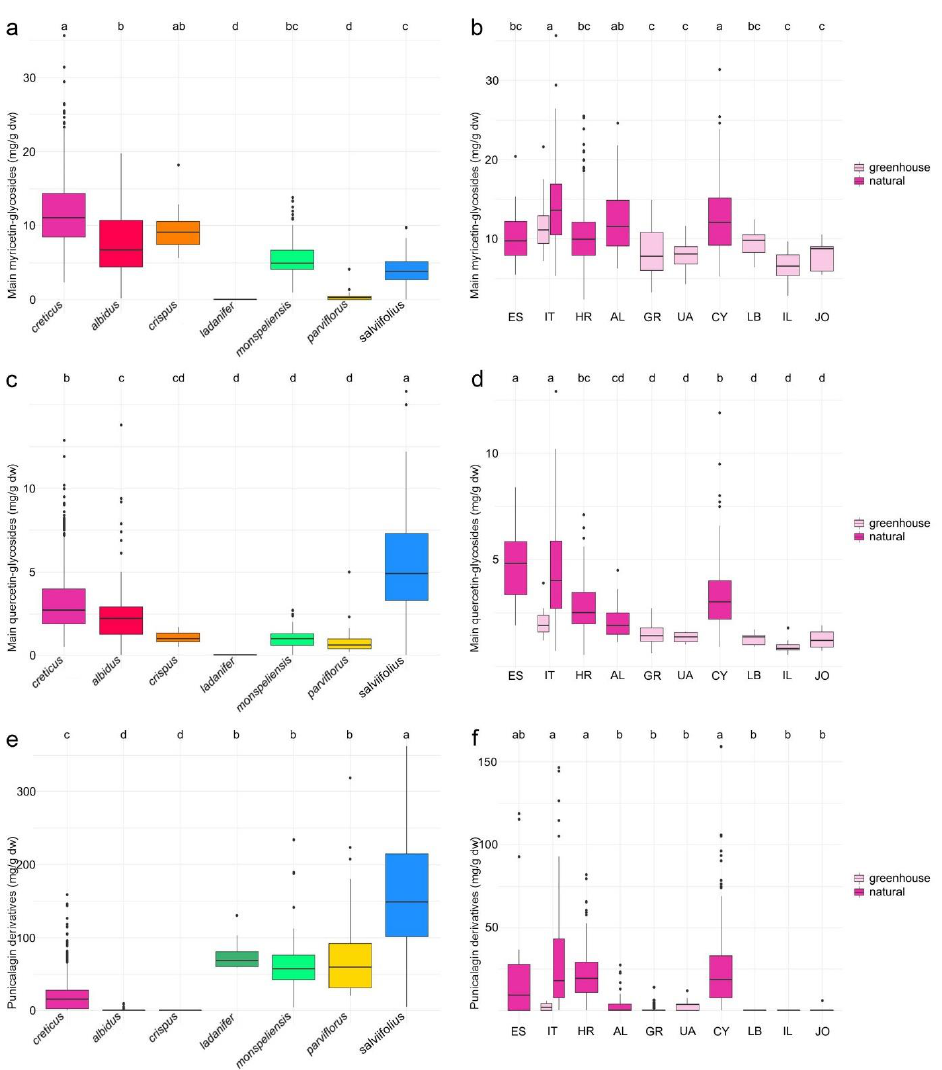
Figure 1. Comparison of ( a ) myricetin glycoside amounts (mg/g dry wt), ( c ) quercetin glycoside amounts (mg/g dry wt) and ( e ) amount of punicalagin derivatives (mg/g dry wt) of C. creticus , C. albidus , C. crispus , C. ladanifer , C. monspeliensis , C. parviflorus and C. salviifolius . Species with the same letter on top do not differ significantly from each other (groups were determined by Tukey honestly significant difference (HSD) test, alpha = 0.005). Comparison of ( b ) myricetin glycoside amounts (mg/g dry wt), ( d ) quercetin glycoside amounts (mg/g dry wt) and ( f ) ellagitannin amounts (mg/g dry wt) of C. creticus populations originating from Spain to Jordan. Colors determine natural (pink) or greenhouse origin (light pink) of plant material. Countries with the same letter on top do not differ significantly from each other (groups were determined by Tukey HSD test, alpha = 0.005). ES = Spain (three populations), IT = Italy (two cultivated populations and eleven natural populations), HR = Croatia (16 populations), AL = Albania (four populations), GR = Greece (four populations), UA = Ukraine (one population), CY = Cyprus (28 populations), LB = Lebanon (one population), IL = Israel (one population), JO = Jordan (one population).